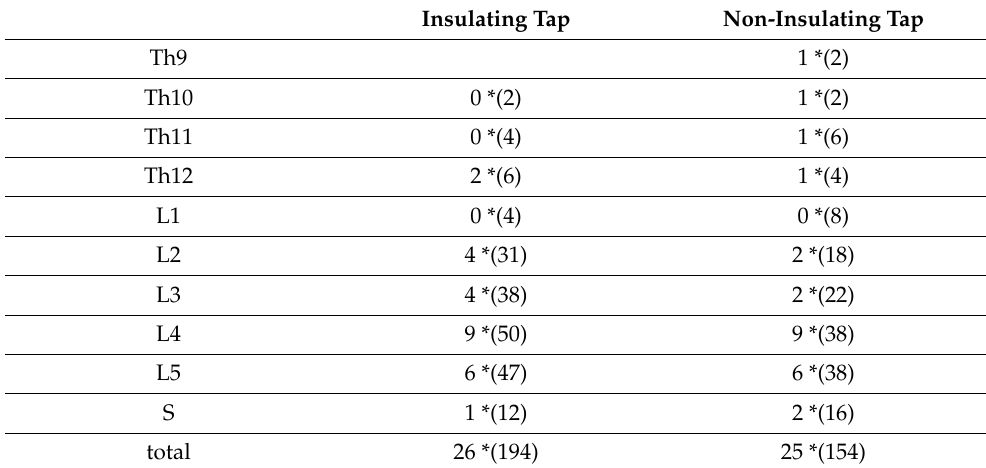
Table 3. The level of vertebrae perforating the medial wall of the pedicle in each group.